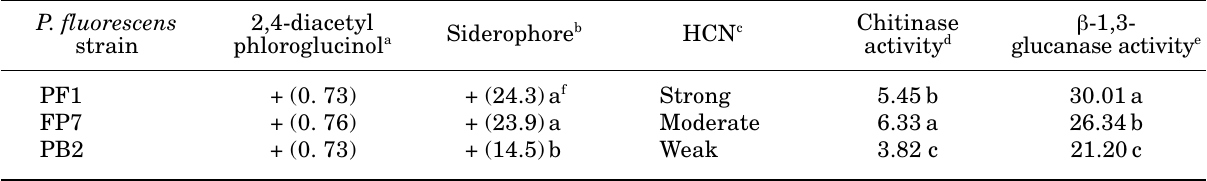
Table 1. Secondary metabolites and lytic enzymes of Pseudomonas fluorescens strains. P.